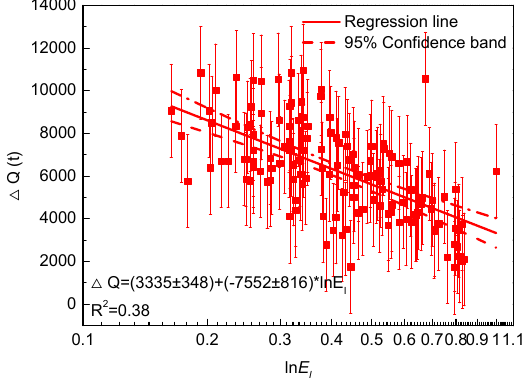
Figure 5. Production increase versus Engineering composite index.